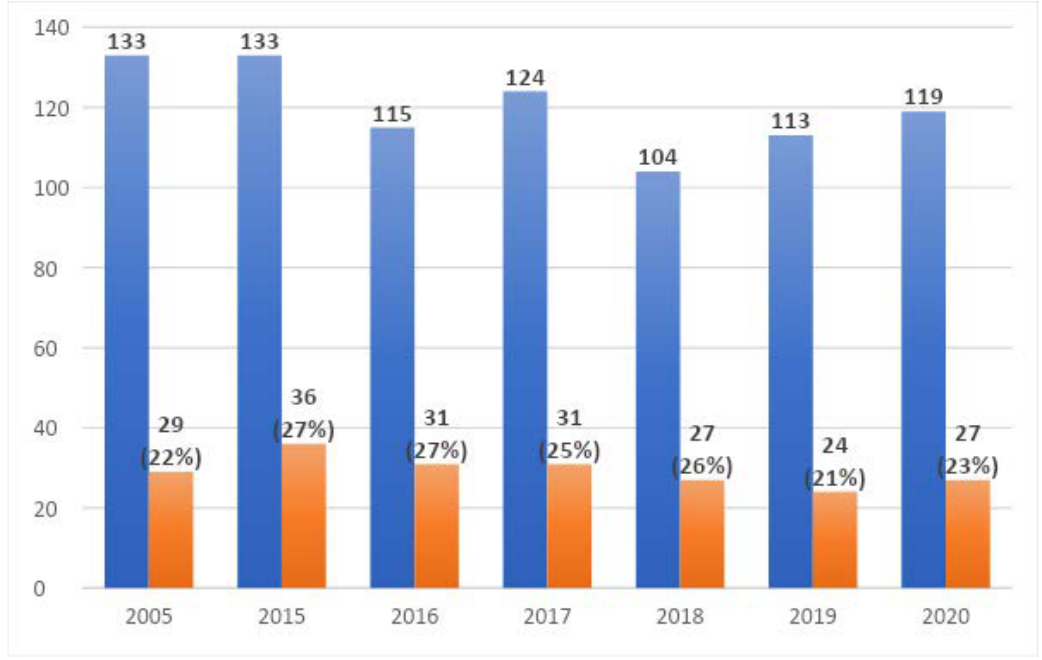
Figure 4. Mycological tests performed in the NICU in the studied years, including positive results.